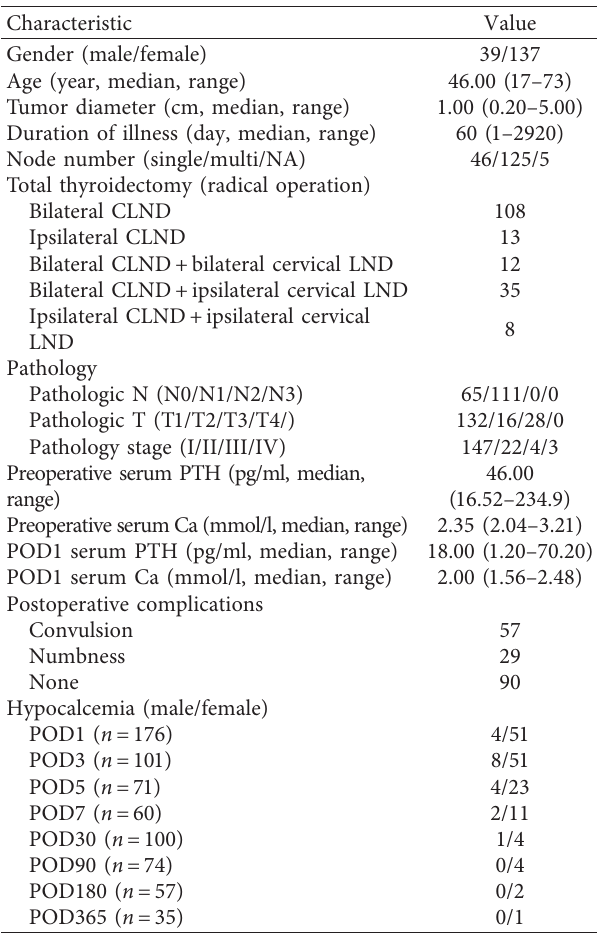
Table 1: Demographic, clinical, and biochemical characteristics of the 176 patients with papillary thyroid carcinoma undergoing radical